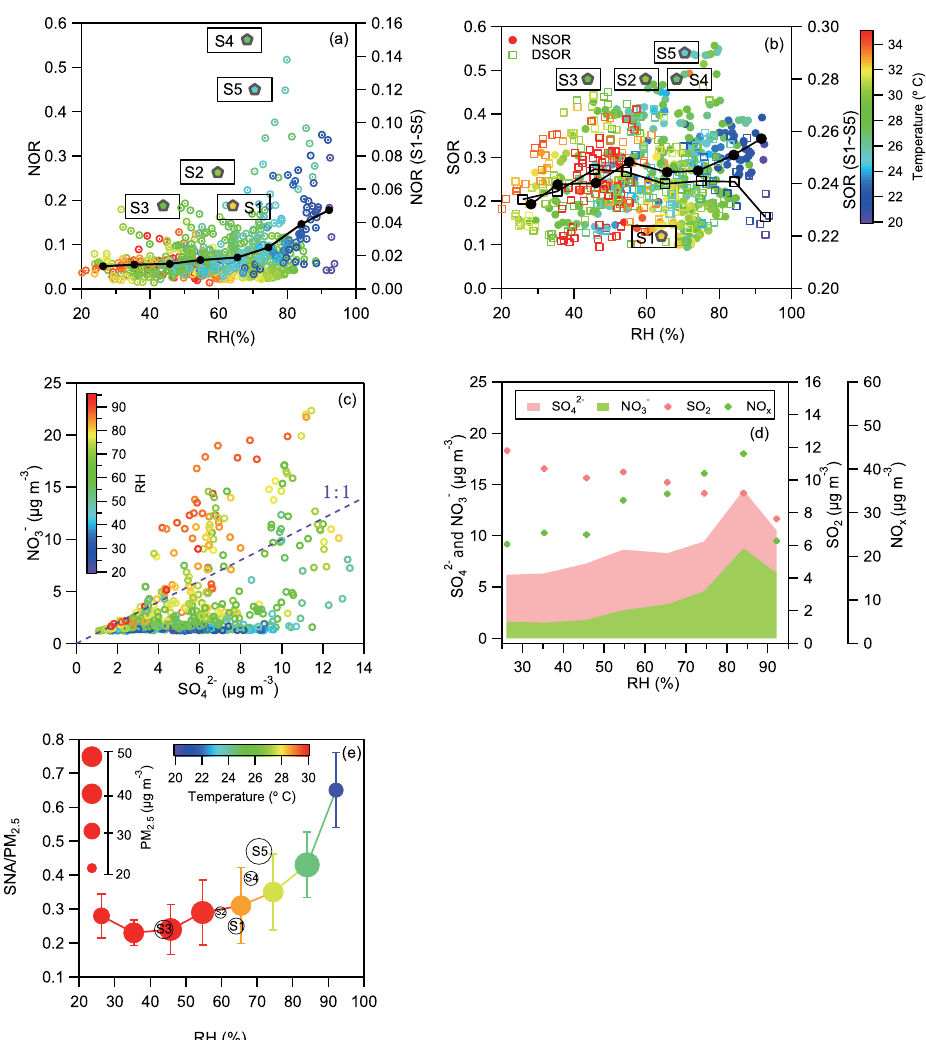
Figure 9. Hourly nitrogen oxidation ratio (NOR) (a) and sulfur oxidation ratio (SOR) (b) plotted against RH, where the colored dots represent temperature. The pentagons in (a, b) denote the mean values of NOR and SOR in each stage and the values can be derived from the right axis; DSOR and NSOR in panel (b) represent the daytime and nighttime SOR values, respectively. (c) The relationship between hourly sulfate and nitrate, where the colored dots represent RH. (d) Hourly SO 2 − , NO − , SO 2 , and NO x as a function of RH. (e) The ratio of 4 3 SNA / PM 2 . 5 as function of RH in each 10% bin. The filled circles are colored by temperature and the sizes of the circles correspond to the mass concentrations of PM 2 . 5 . The error bars refer to one standard deviation of the SNA / PM 2 . 5 values. The open circles represent the mean value of the five